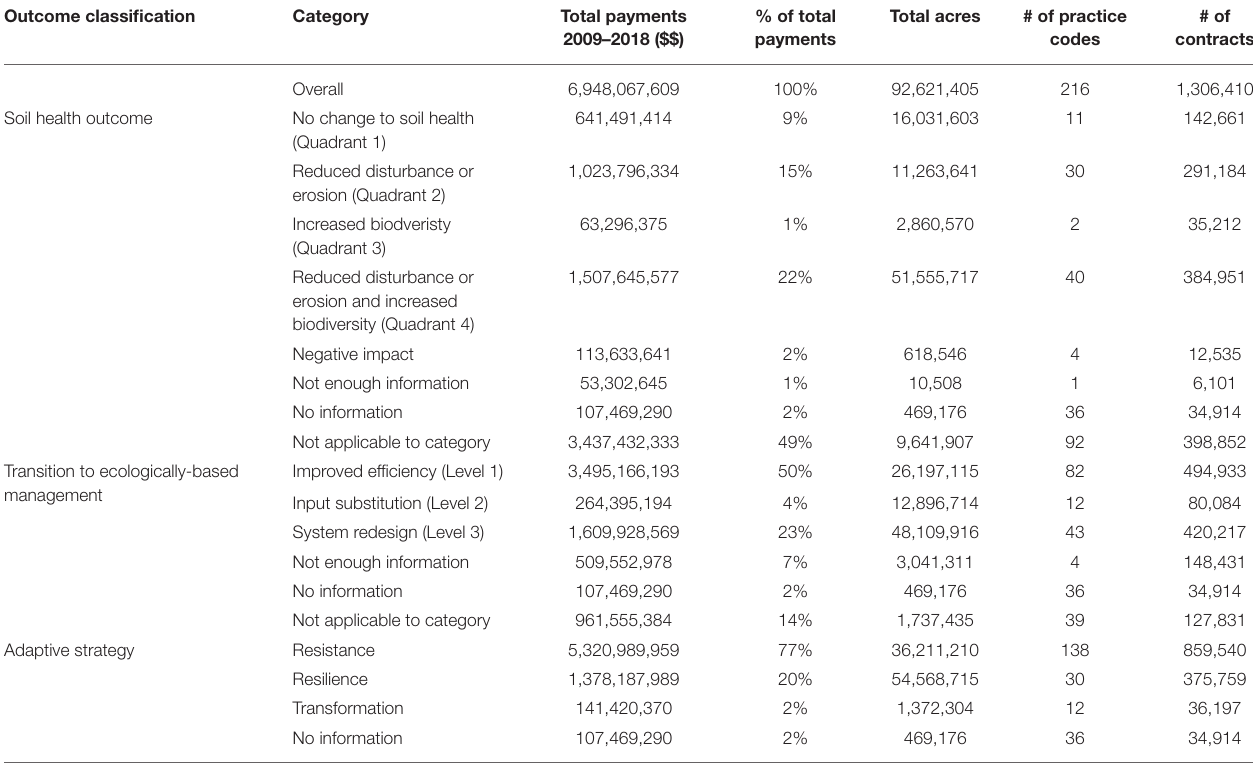
TABLE 2 | Dollars allocated to practices that within each of the different classifications and categories included in our analysis. Outcome